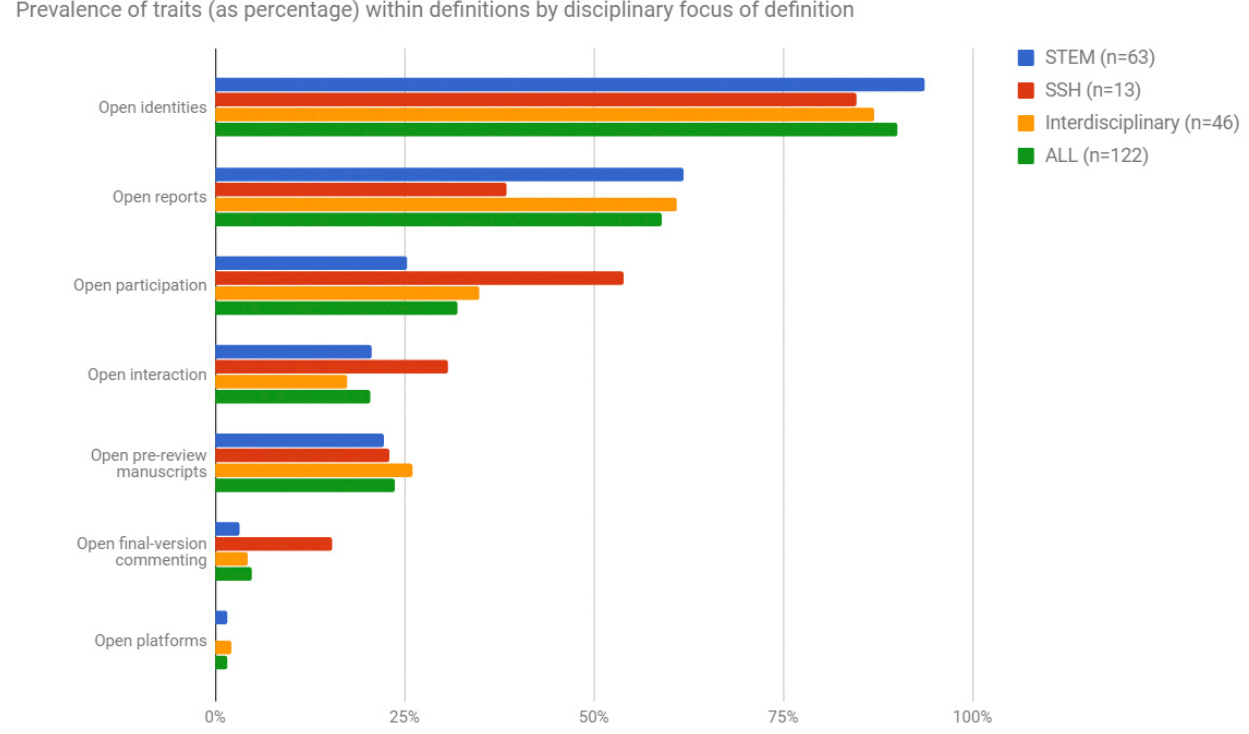
Figure 6. Prevalence of traits (as percentage) within definitions by disciplinary focus of